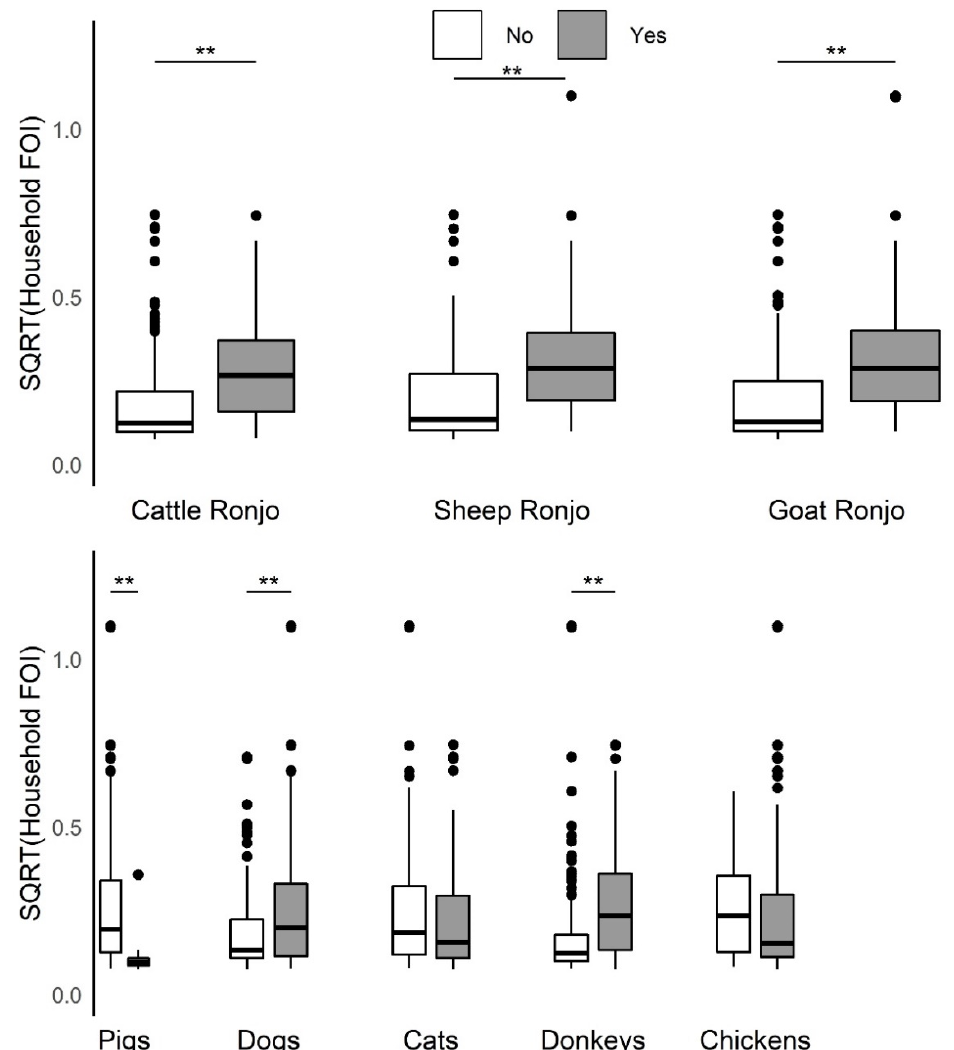
Figure 4. Boxplots of the distribution of the household herd force of infection (FOI, square root transformed, unit = year − 1 ) by seasonal grazing camp attendance for each species in the past 12 months and presence / absence of additional domestic species managed at the household. There was a significant increase (Kruskal–Wallis test, p -value < 0.005) in the household herd FOI for households that reported cattle, sheep, or goats going to a seasonal grazing camp (‘ronjo’) in the past 12 months as well as households that reported having dogs or donkeys. Domestic pigs were associated with a significant decrease in household herd FOI. ** Comparison significant ( p < 0.005) by Kruskal–Wallis test.